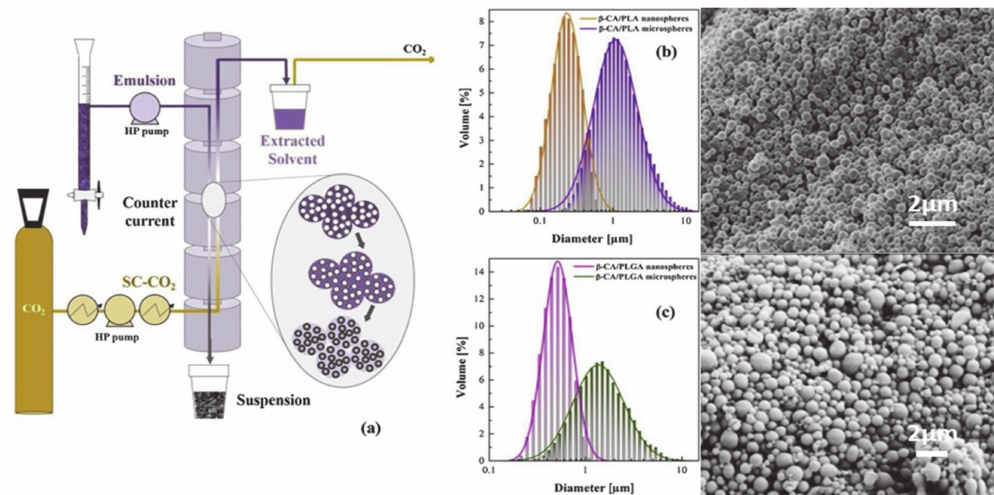
Figure 9. Left side. Schematic representation of the SFEE process ( a ). Size distributions of PLA ( b ) and PLGA ( c ) particles showing the possibility of varying particle sizes by modification of the initial droplet size in the emulsion. Right side : SEM images of PLLA loaded particles obtained from the emulsion after application of the SFEE method. Reprinted with permission from [113], Elsevier,